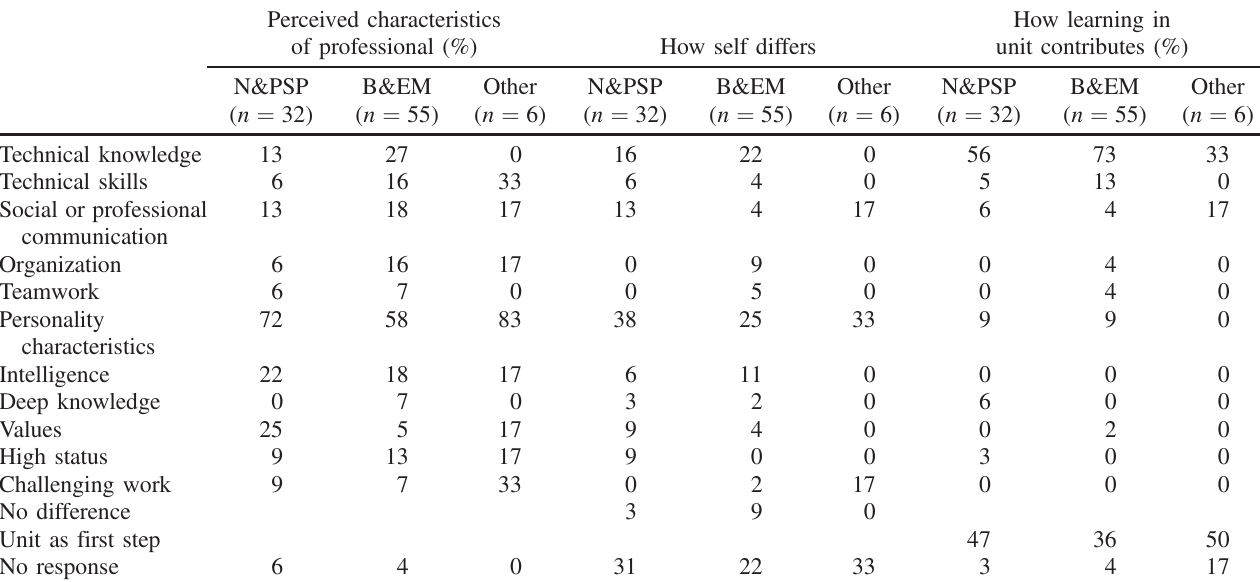
TABLE II. Student perspectives of the characteristics of professionals in their chosen career, how the self differs from this, and how learning in the unit will contribute to development as professional, by occupational grouping (%). Note that N & PSP ¼ Natural and physical science professionals, B & EM ¼ Building and engineering